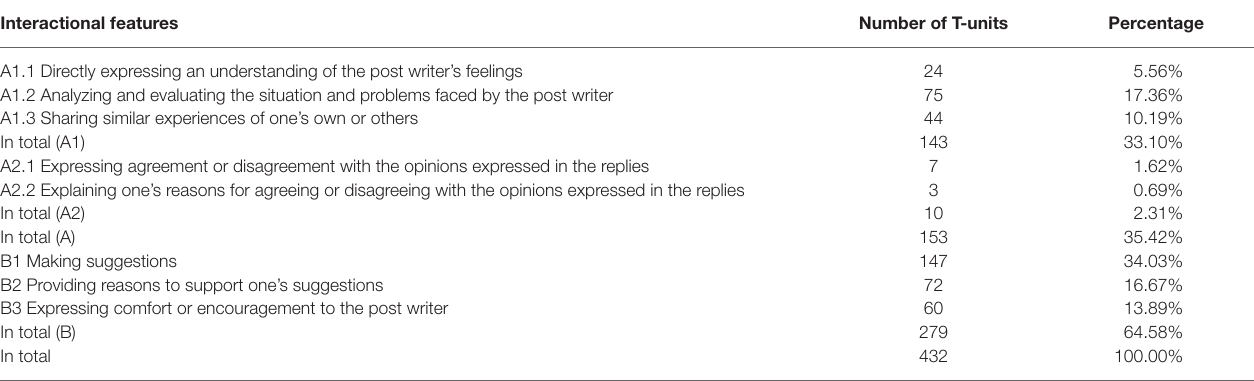
TABLE 3 | Frequency counts and percentages of each interactional feature.